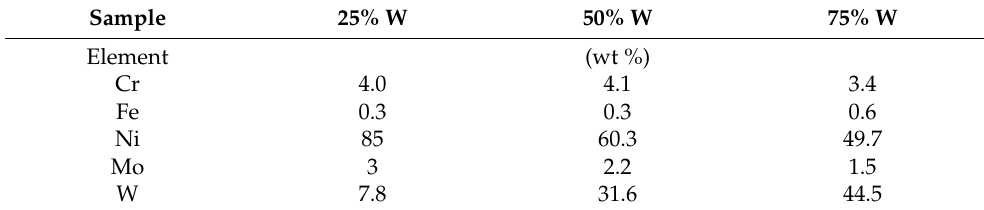
Figure 3. Results of local energy-dispersive spectrometry (EDS) analysis on the cross section of 75% W sample. Table 2. XRF results from the surface of W–Ni claddings on a steel substrate.